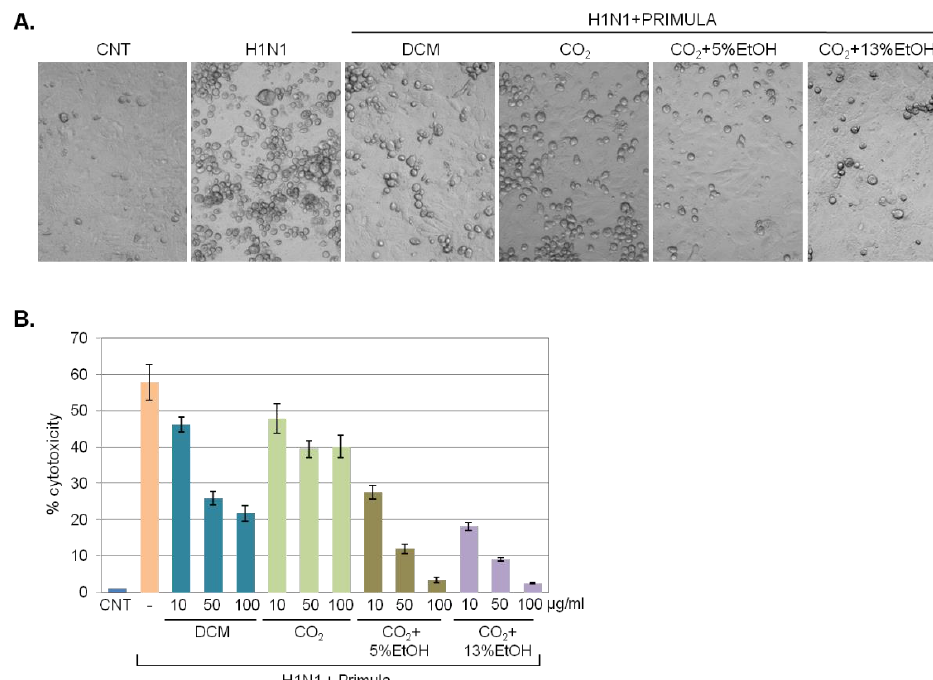
Figure 3. Virucidal effects of P. veris supercritical extracts. ( A ) Microphotographs of MDCK cells infected with H1N1 (MOI = 0.2) or with virus that had been pre-incubated for 1 h with 50 µ g/mL of P. veris extract isolated by using supercritical CO 2 in the presence or absence of 5% or 13% EtOH. As control, DCM extracts of P. veris were used. Rounded cells are indicative of virus-induced cytopathic effects. ( B ) MDCK cells were infected with H1N1 (MOI = 0.2) or with virus that had been pre- incubated for 1 h with 10, 50 or 100 μg/mL of P. veris extracts, as indicated. Virus-induced cytolytic effects were assessed by LDH release assays. CNT: uninfected control cultures. 2.3. Prophylactic Effects of Primula Plant Extracts against Influenza Virus-Induced Cell Lysis